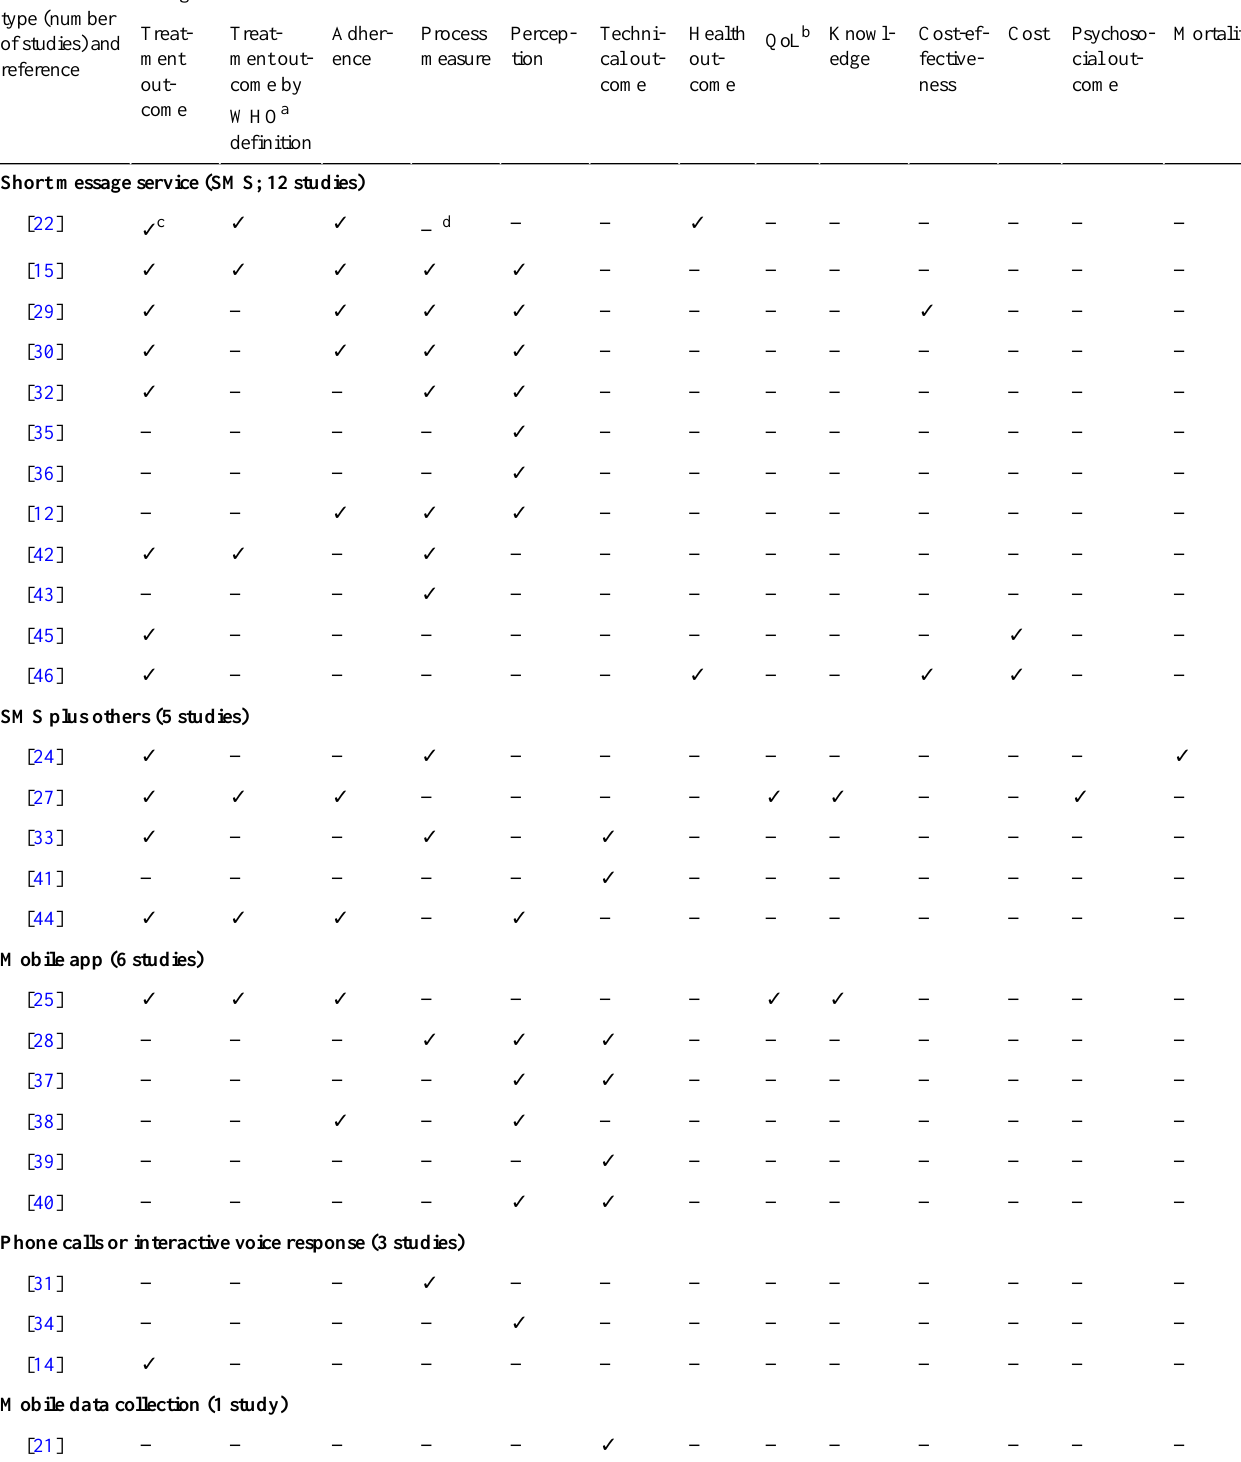
Table 2. Reported outcomes by mHealth intervention